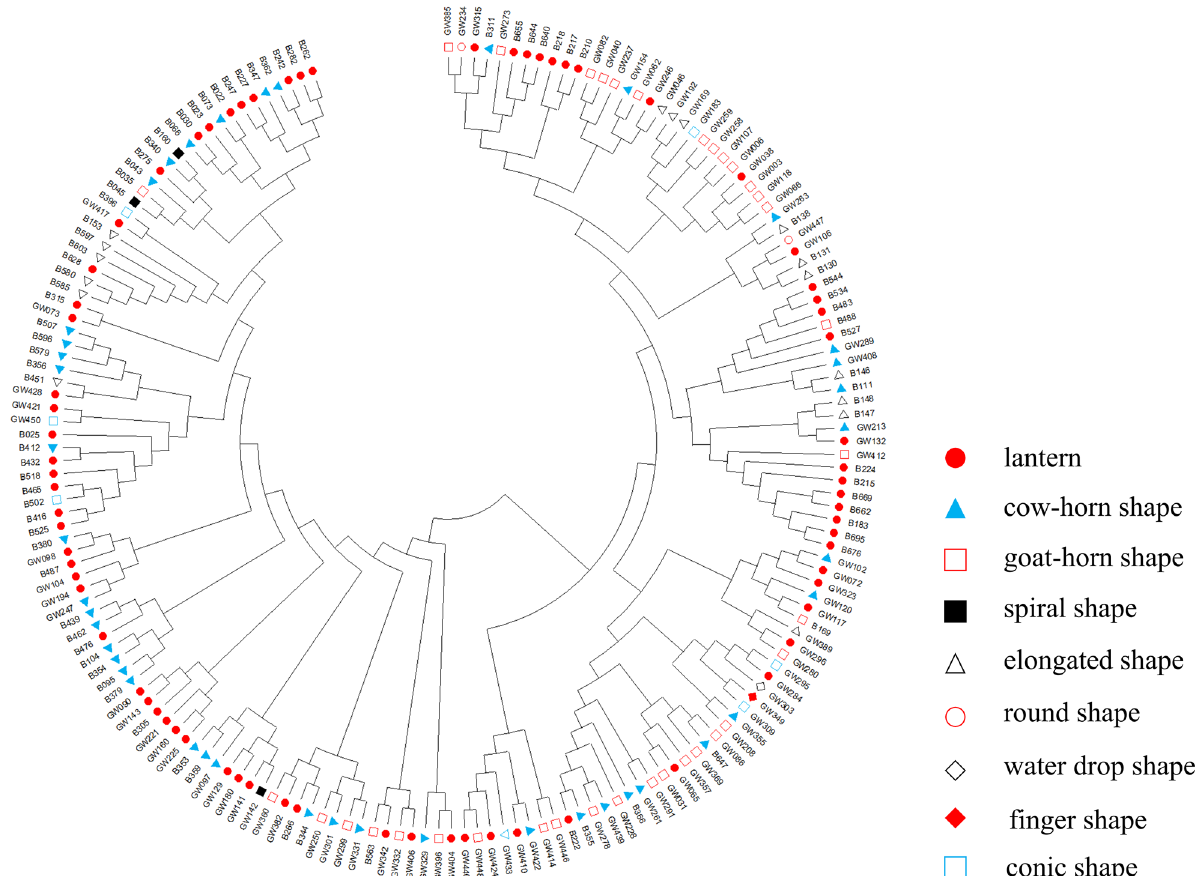
Figure 3. Phylogenetic tree of 94 local landraces (No. start with GW) and 85 current breeding lines (No. start with B) based on SSR and InDel markers using the NJ clustering method. (UPGMA 5.10, https:// www. megas oftwa re.